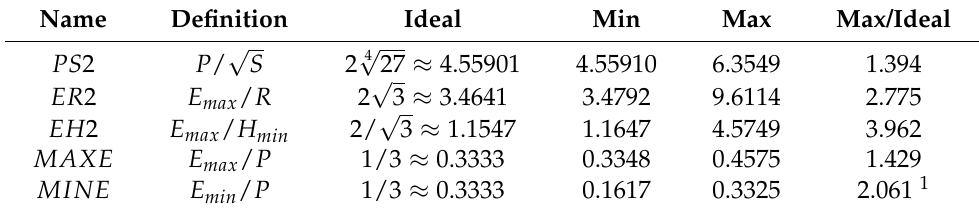
Figure 3. Quality of the 3D globe mesh assessed with the following measures: Left − ER max , EH max and SV max . m right − number of vertices NO_VER and number of tetrahedra NO_TET. The mesh has been generated with TetGen program with the following parameters: minimum dihedral angle DA, maximum EH value, maximum element volume VT. The ranges of the axes are are top —fixed values of DA min and VT max , bottom —fixed values of EH max and DA max . The input 2D mesh and the results of its tetrahedralization are presented in Tables 3 and 4. Table 3. Mesh quality of the globe surface